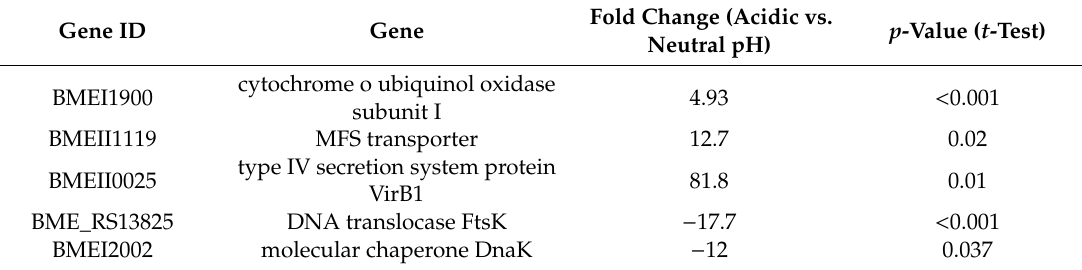
Table 2. Validation of selected genes by